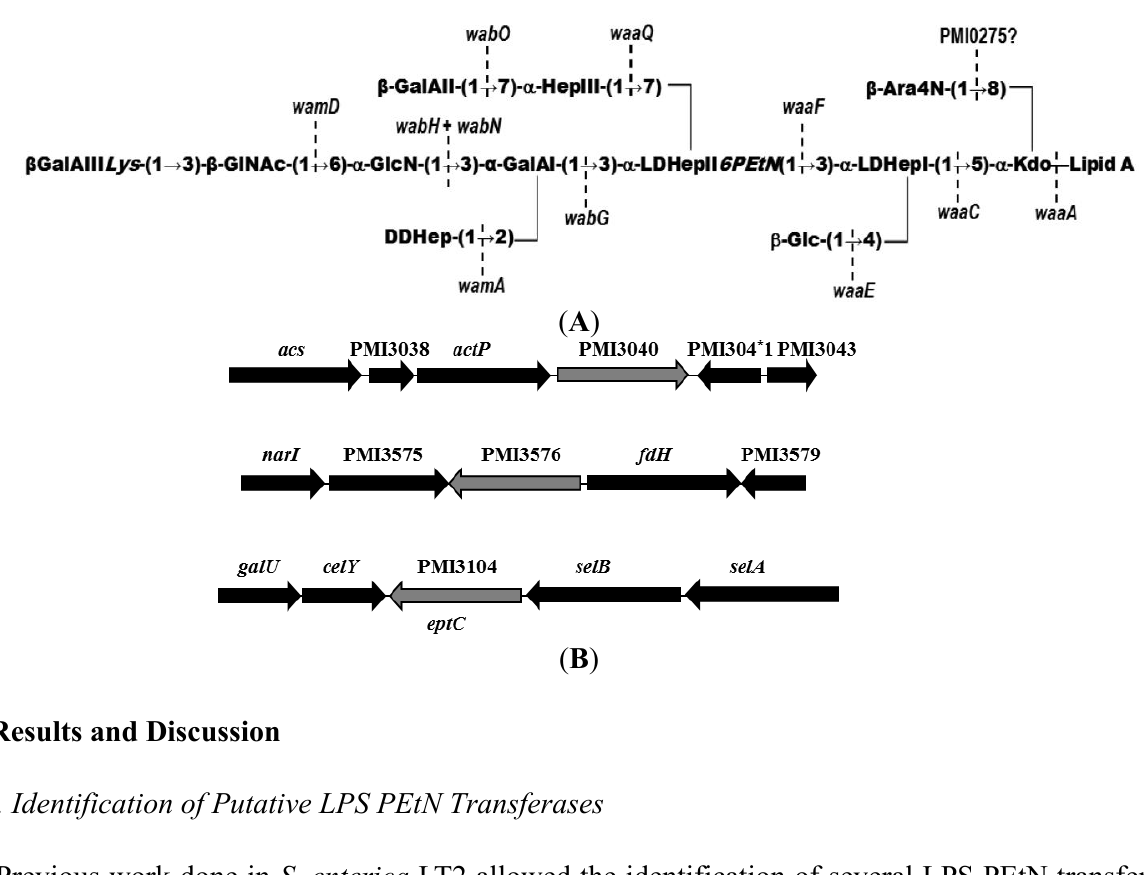
Figure 1. ( A ) P. mirabilis HI4320 core OS structure (50) and genes involved in core biosynthesis (2,3). 3-Deoxy- D -manno-oct-2-ulosonic acid (Kdo), L -glycero- D -manno-heptose ( L , D -Hep), D -glycero- D -manno-heptose (D,D-Hep), glucosamine (GlcN) galactunonic acid (GalA), N -acetylglucosamine (GlcNAc), glucose (Glc), 4-amino-4-deoxy- L -arabinose ( L -Ara4N), phosphoethanolamine (PEtN), and lysine (Lys); ( B ) Location in the genome